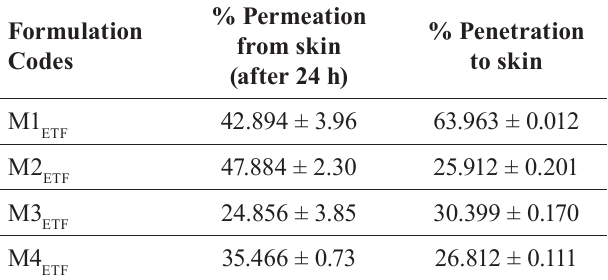
, M2 , M3 and M4 ETF ETF ETF